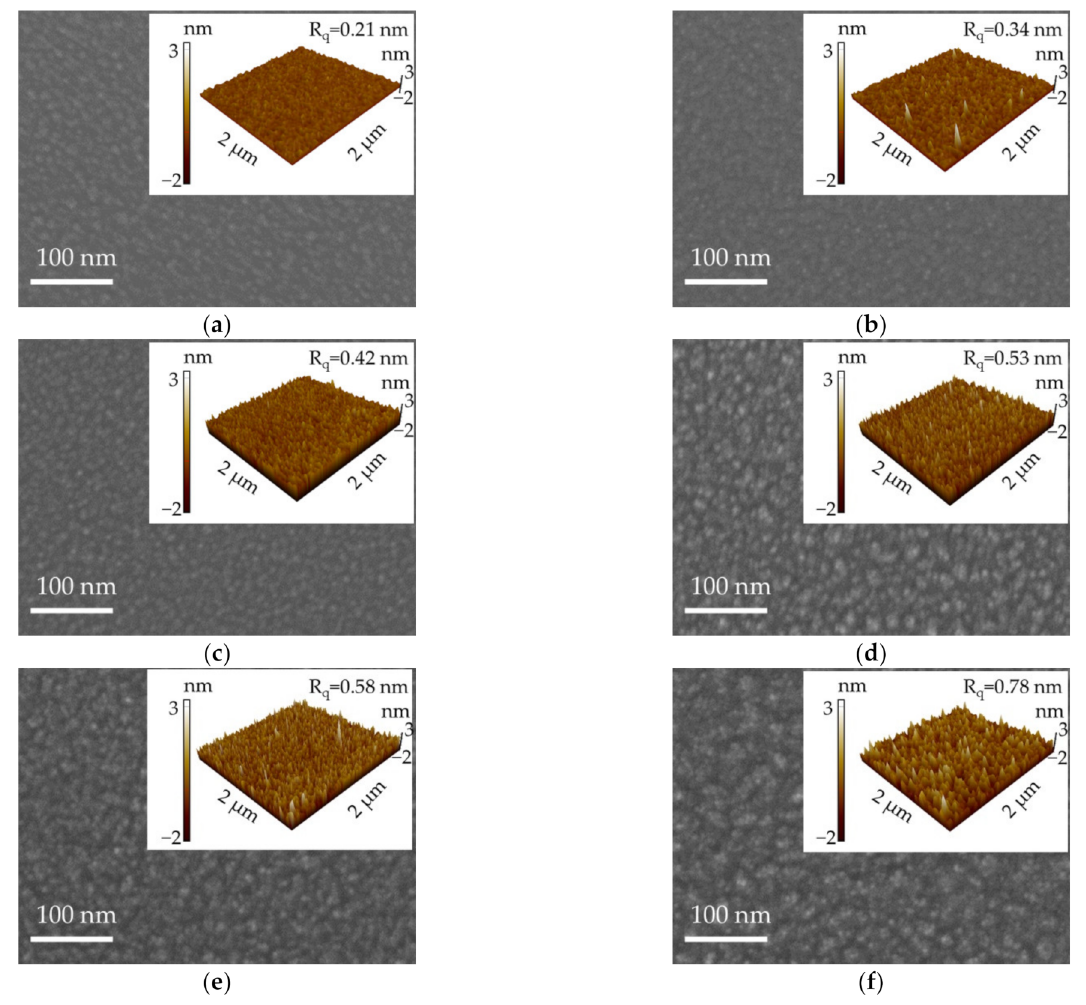
Figure 5. SEM images for the PEALD GaN films deposited at ( a ) 200, ( b ) 250, ( c ) 300, ( d ) 350, ( e ) 400, and ( f ) 450 ◦ C. The insets were the corresponding AFM